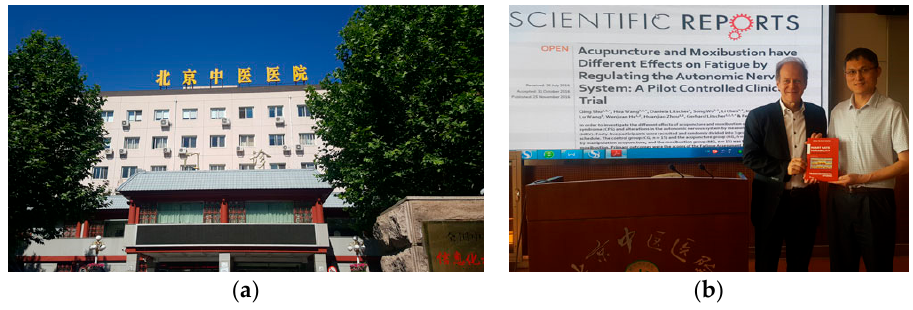
Figure 12. Project Discussion at the Beijing Hospital of TCM affiliated to CMU ( a ) Professor Liu Cun Zhi (right) and Professor Gerhard Litscher ( b ) Beijing, 26 May 2017.